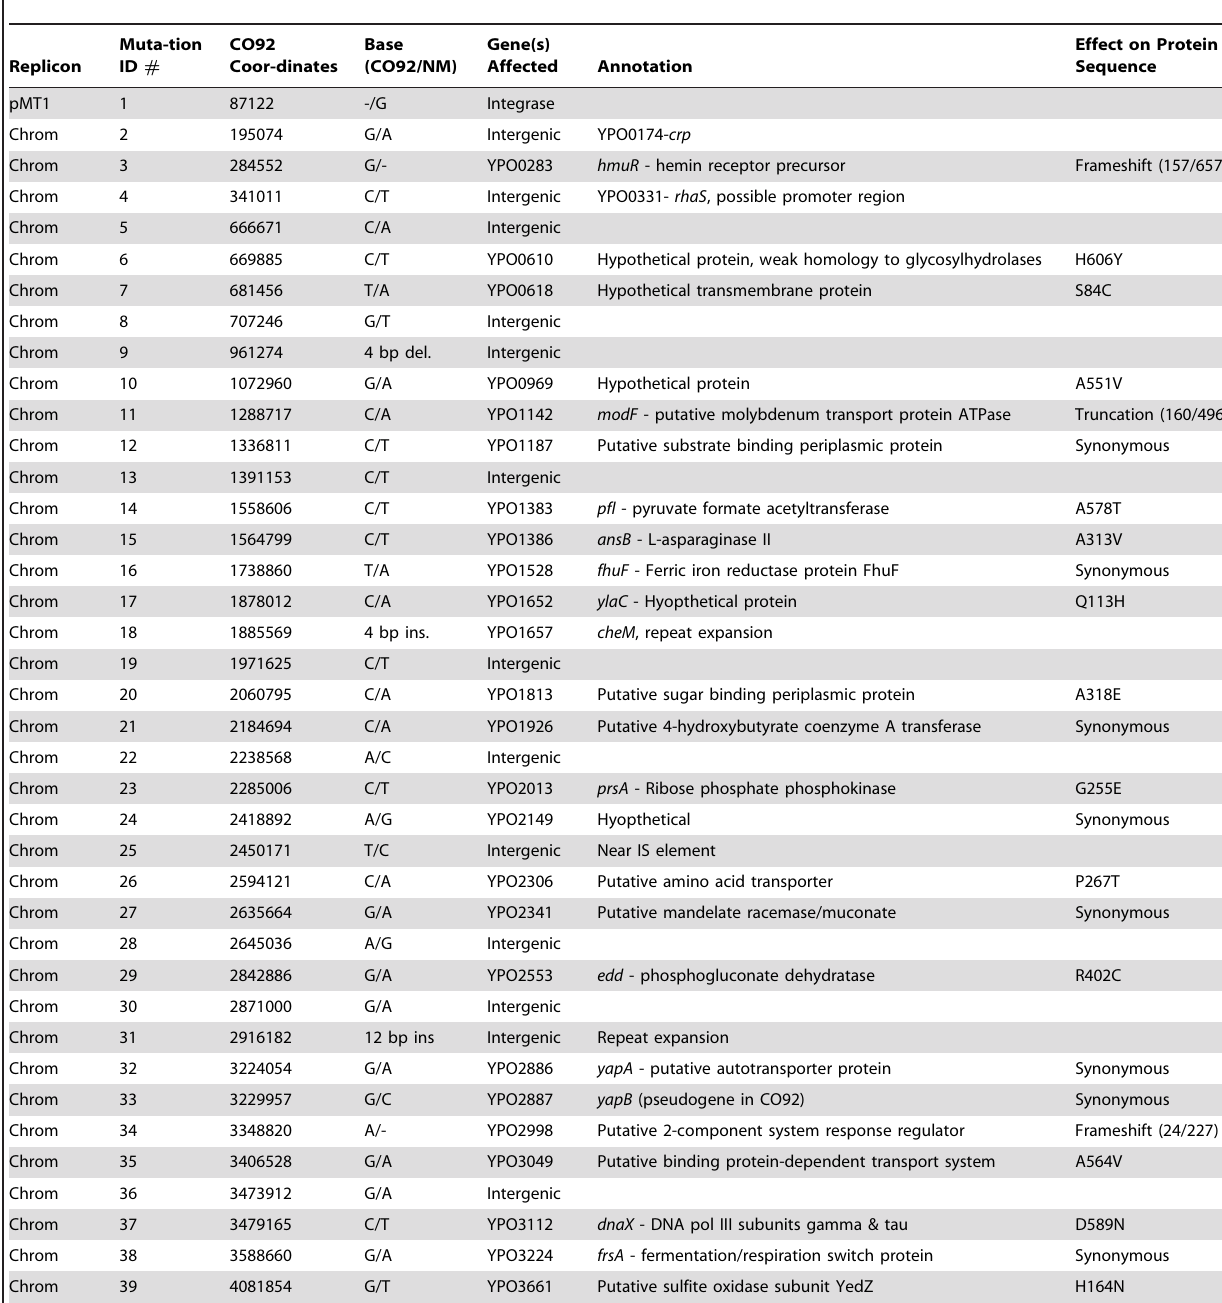
Table 2. Mutations Identified in New Mexico Y. pestis